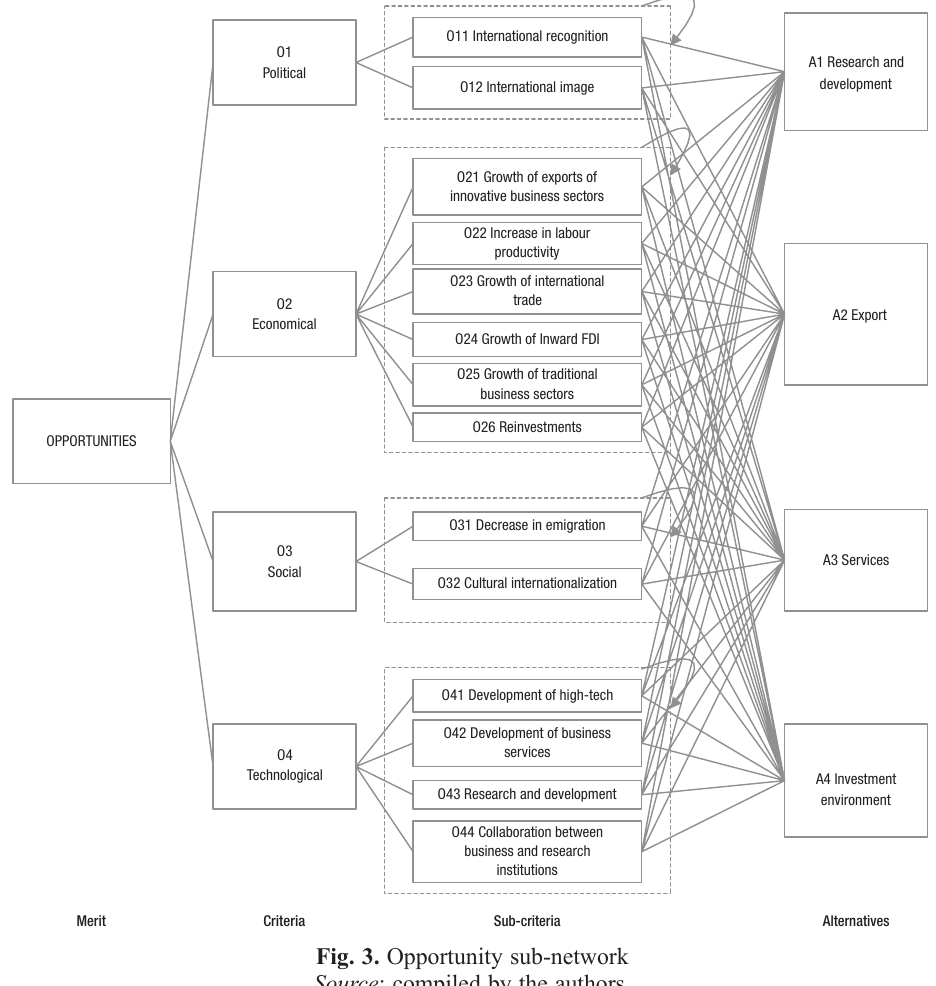
Fig. 3. Opportunity